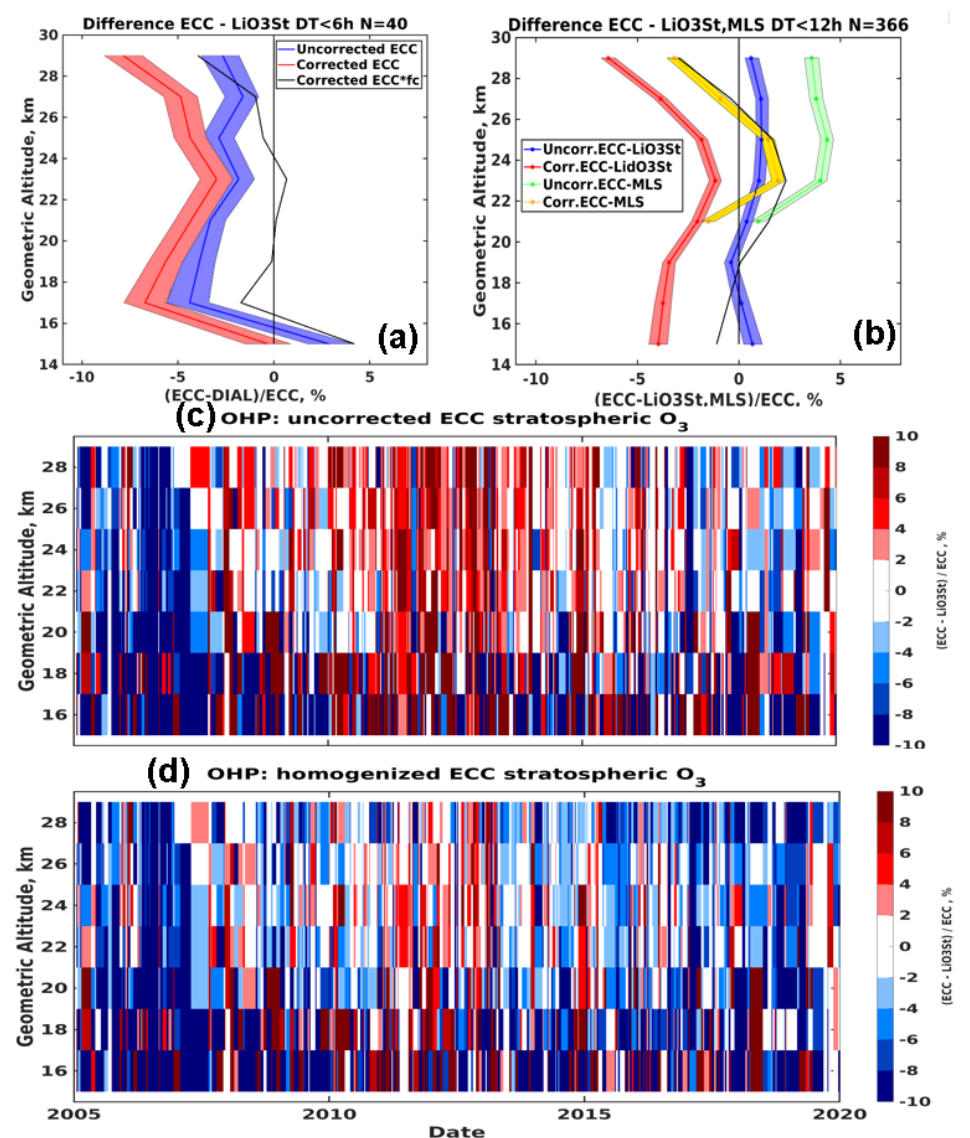
Figure 6. Mean relative ECC minus LiO3St O 3 concentration differences (in %) between 14 and 30km for uncorrected (blue) and homog- enized (red) ECC for (a) the 40 coincident ( < 6h) profiles (see Fig. 3) and (b) the 366 profiles within 12h during the MLS measurement period. Shaded areas represent the standard uncertainty in the mean difference. The solid black line shows the mean relative differences if the homogenized ECC concentrations are multiplied by N T . The mean relative ECC minus MLS O 3 concentration differences are shown in (b) for uncorrected (green) and homogenized (yellow) ozonesonde. The time evolution of the relative ECC minus LiO3St O 3 concentration differences (in %) are shown in (c) for uncorrected and (d) for homogenized ECC using the 366 profiles with a 12h time